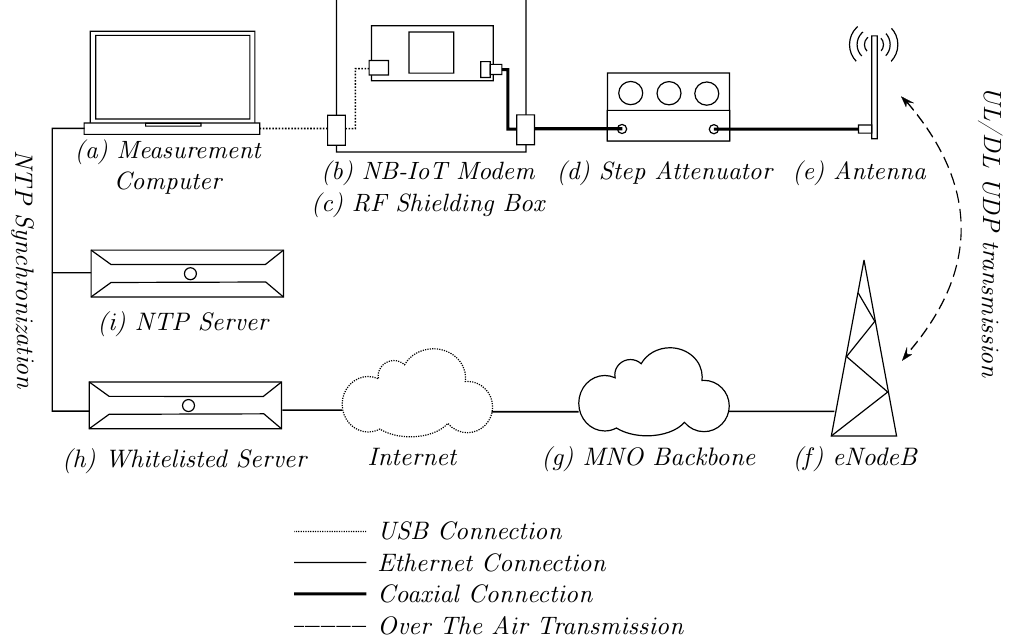
Figure 5. The measurement architecture used for the physical and application layer